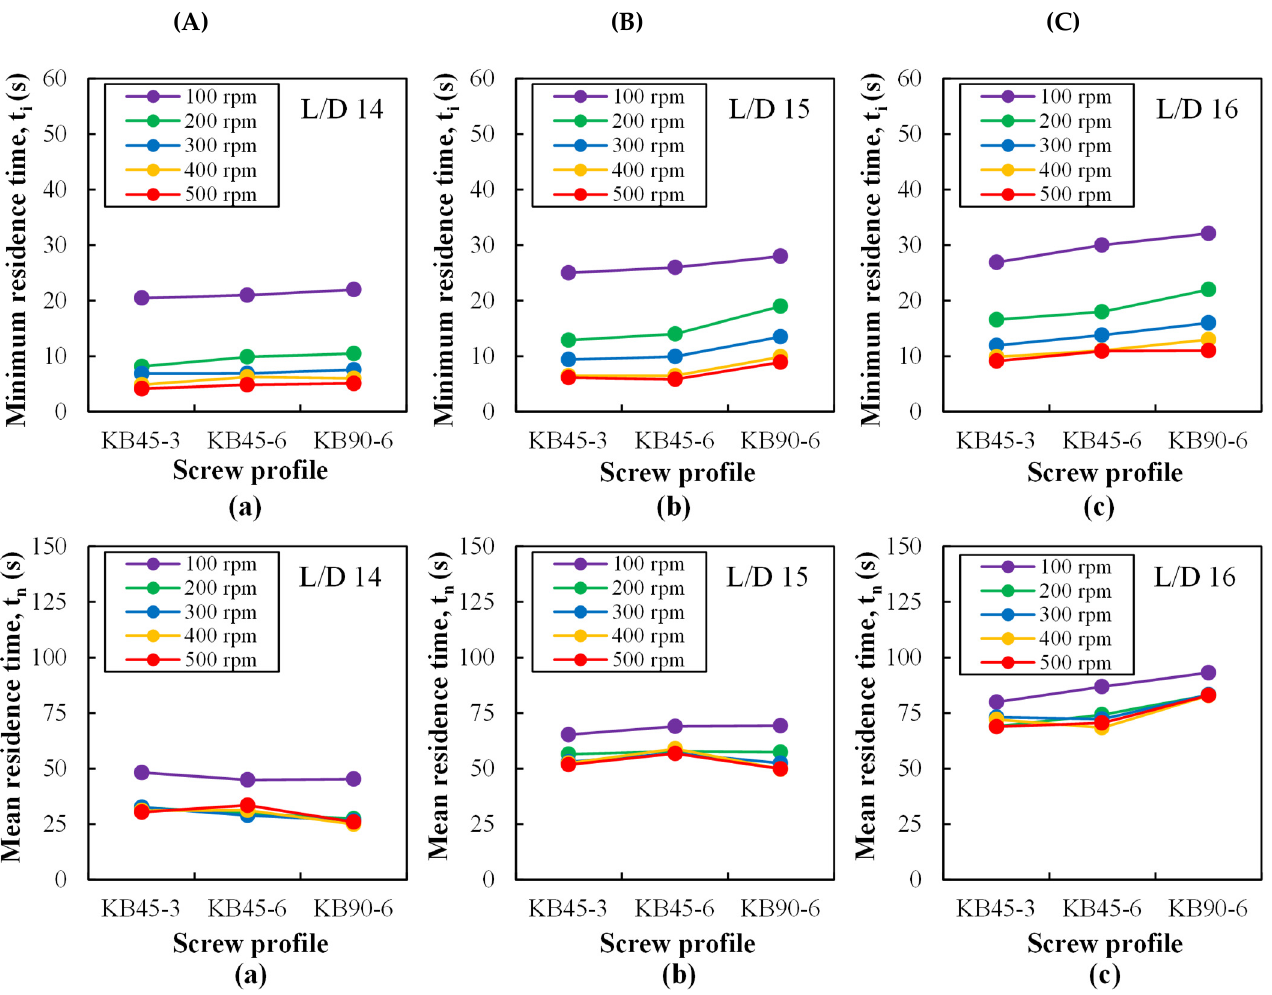
Figure 7. Minimum ( t i ) and mean ( t n ) residence times (s) measured with the barrel set to 230 °C along the mixing zone at ports: ( a ) L/D = 14, ( b ) L/D = 15, and ( c ) L/D = 16 for different kneading blocks ( A : KB45-3, B : KB45-6, and C : KB90-6) and screw speeds (100 to 500 rpm).